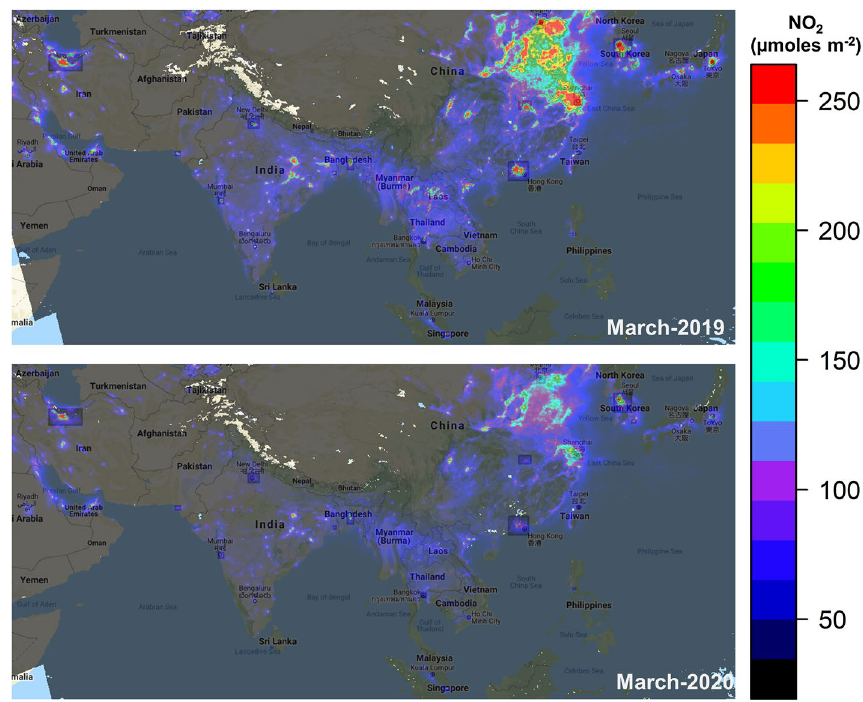
Figure 2. Spatial patterns indicating a drastic drop in average NO 2 concentration in March 2019 and 2020 in the Asia-Pacific region. Maps were created through Google Earth Engine (https:// earth engine. google. com/V. 2020) by a co-author, Sawaid